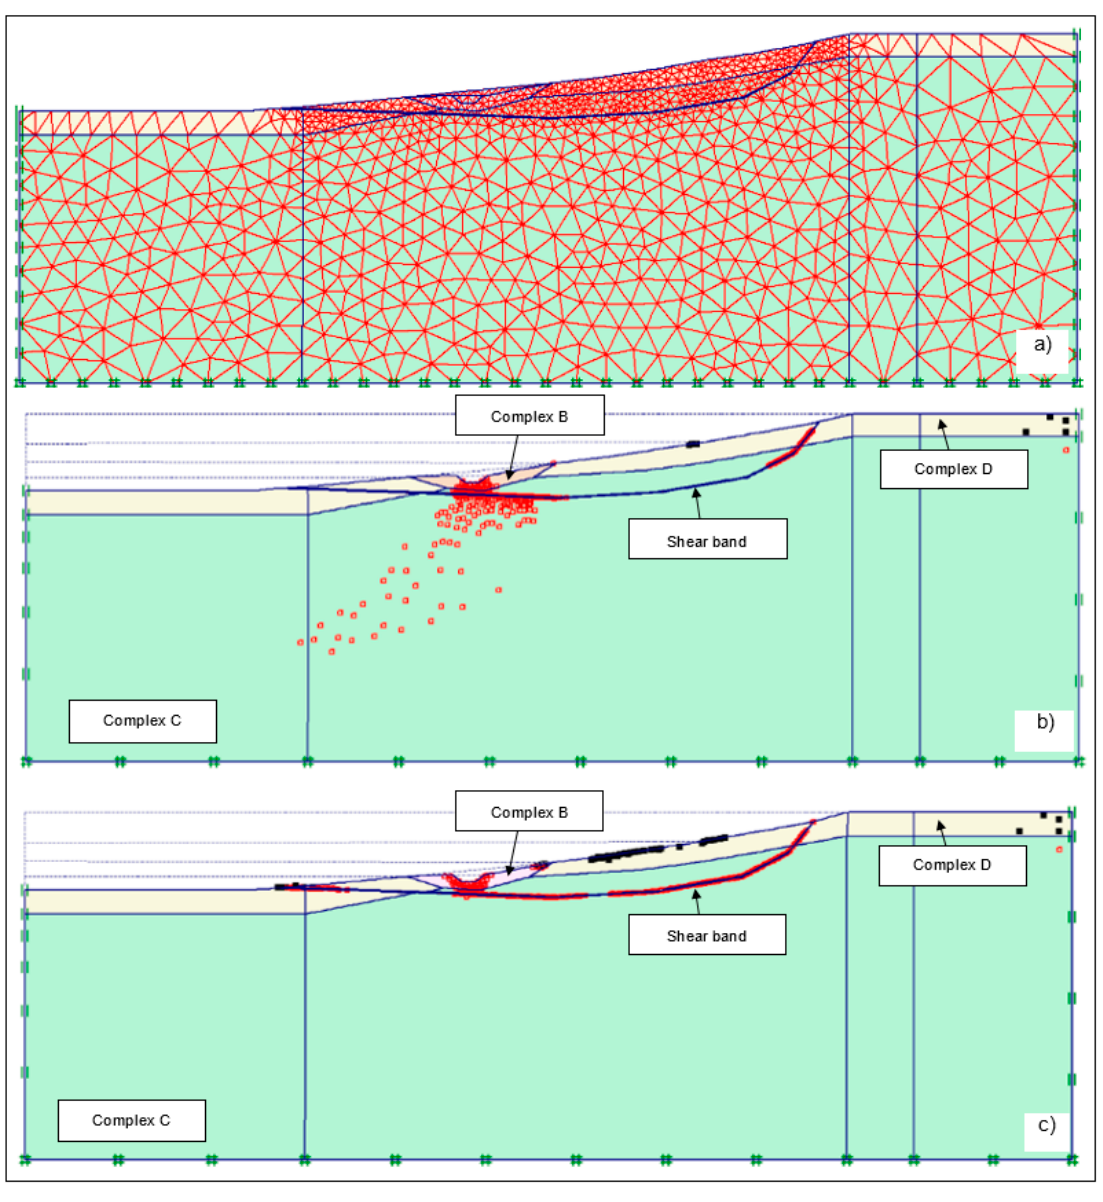
Figure 10. FEM analysis of the Tolve slope (modified from [76]): slope after excavation ( a ), yield points at the end of the undrained excavation ( b ) and at the end of the coupled consolidation, before the occurrence of numerical instabilities ( c ); stages ( b , c ) performed implementing weak soils in complex B (c’ = 6 kPa; ϕ ’ = 24°) and in the shear band (c’ = 0 kPa ; ϕ ’ = 16°).